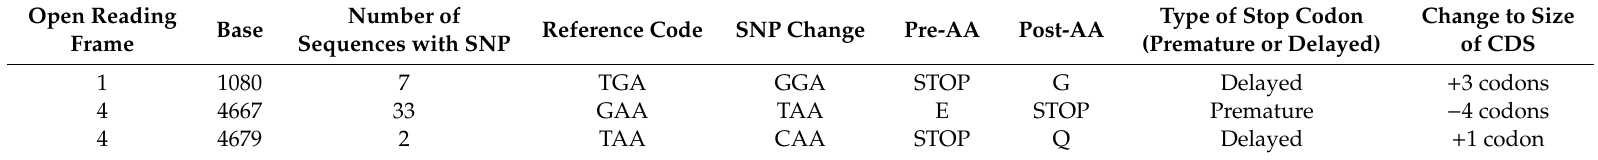
Table 5. Details of premature and delayed stop codons collated from whole